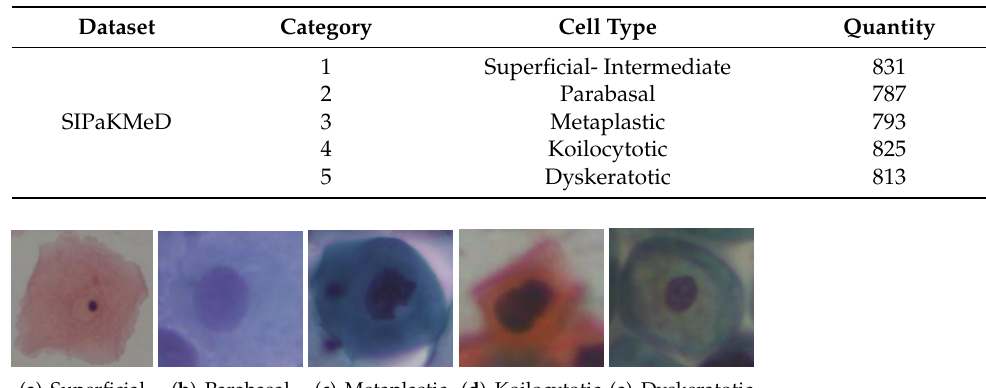
Table 1. SIPaKMeD dataset.